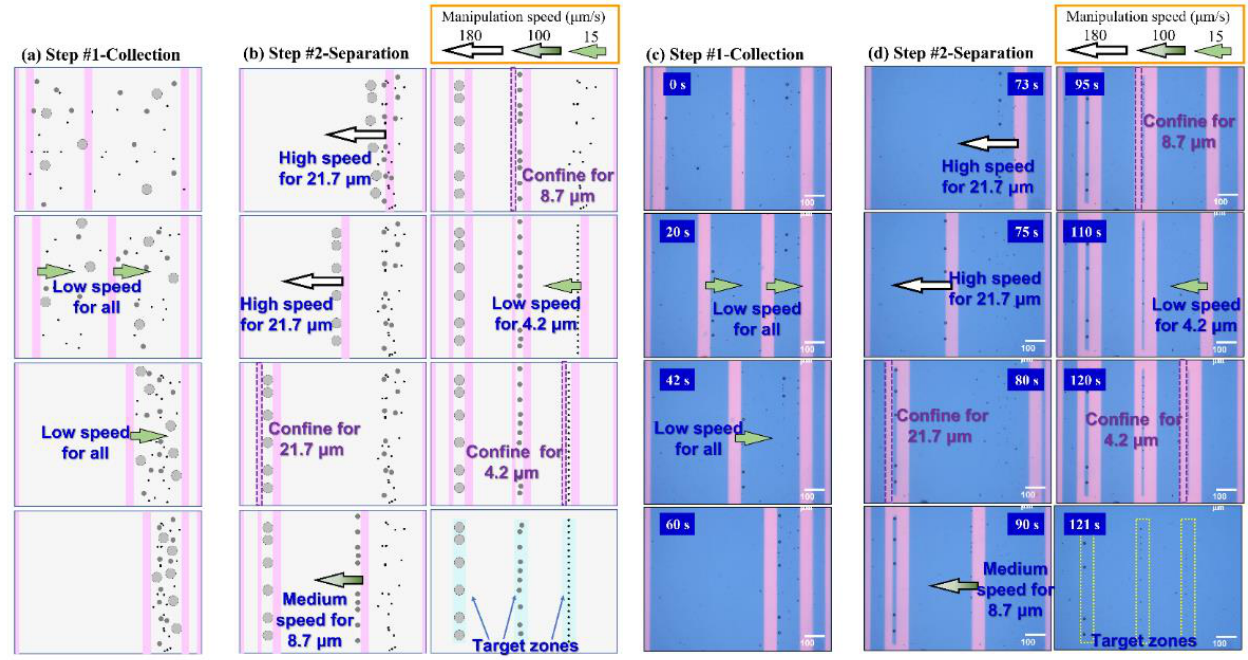
Figure 3. The procedure to generate three different transducer elements, individually constructed using three types of magnetic beads by selected manipulation speed of light patterns movements for two main steps including collection and separation, is shown by the schematic plot and real images captured from operation video: ( a ) schematic plots of Step #1 Collection, ( b ) schematic plots of Step #2 Separation, ( c ) real images of Step #1 Collection, ( d ) real images of Step #2 Separation. With different speeds of light patterns, magnetic beads with different diameters can be collected